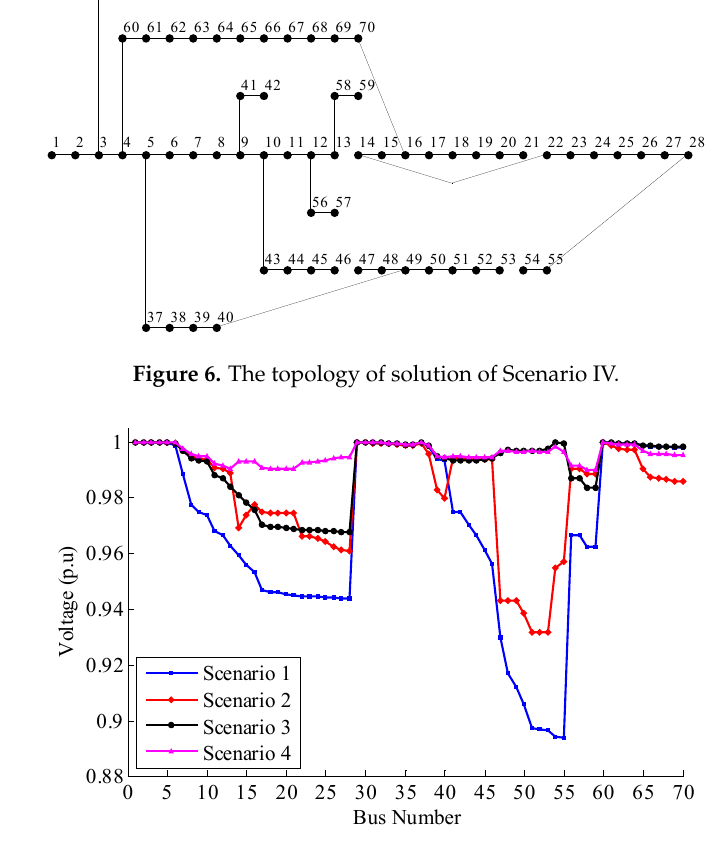
Figure 7. Voltage profiles of PG&E 69-bus system. Table 4. The optimization result of PG&E 69-bus